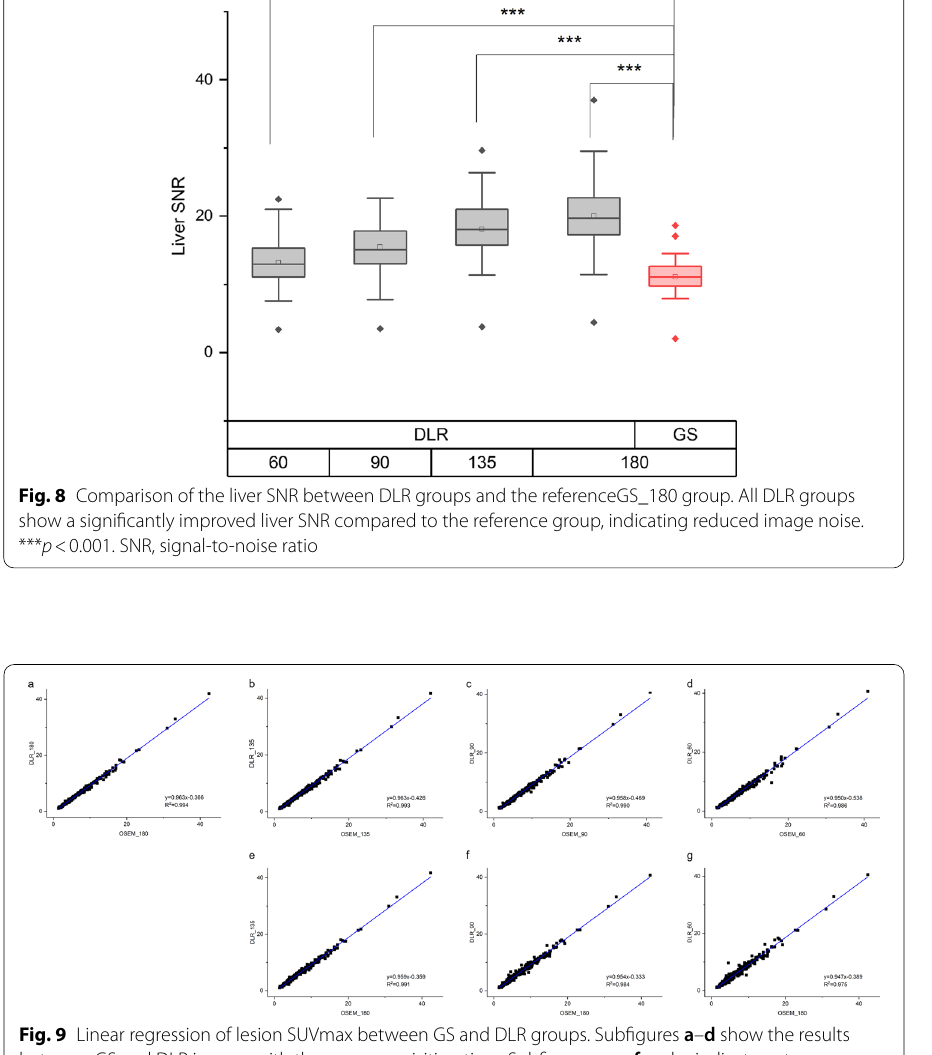
15 mm and a large lesion group with diameters of at least 15 mm [27]. In the small lesion group ( n 196), the TBR was not significantly different between the DLR_180 = group and the reference GS_180 group ( p 0.051) whereas the TBR values in other =